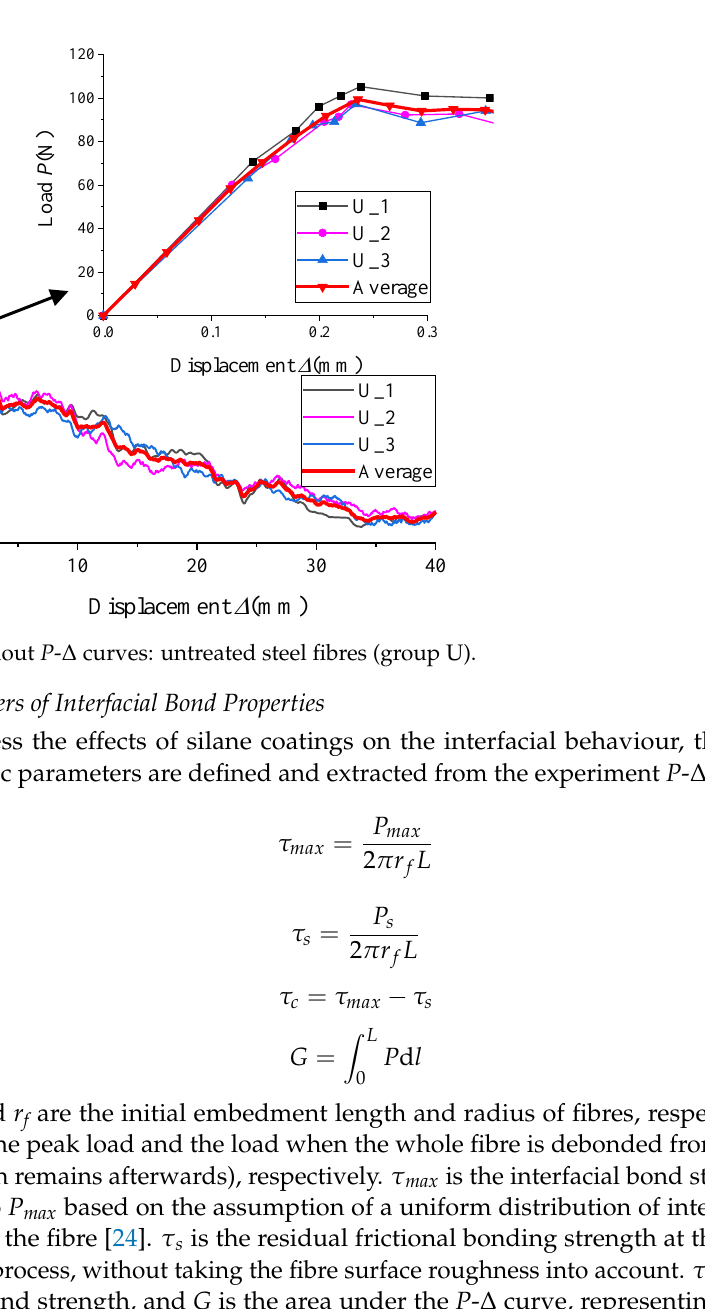
Figure 5. Pullout P - Δ curves: steel fibres treated by Z6020 + H 2 ZrF 6 (group ZH2).